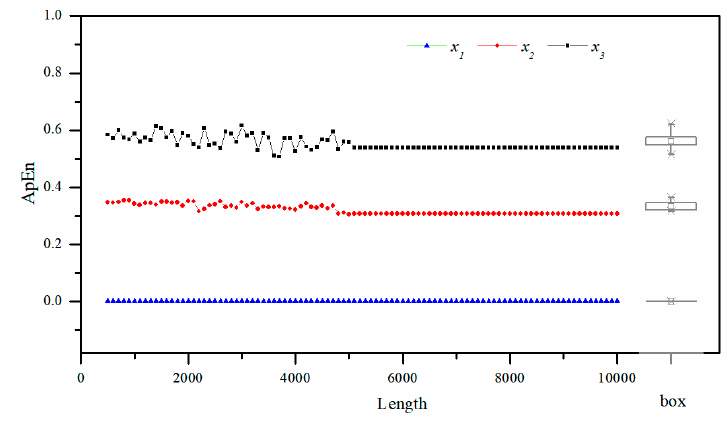
Figure 4. The ApEn values of sub-series with different lengths.